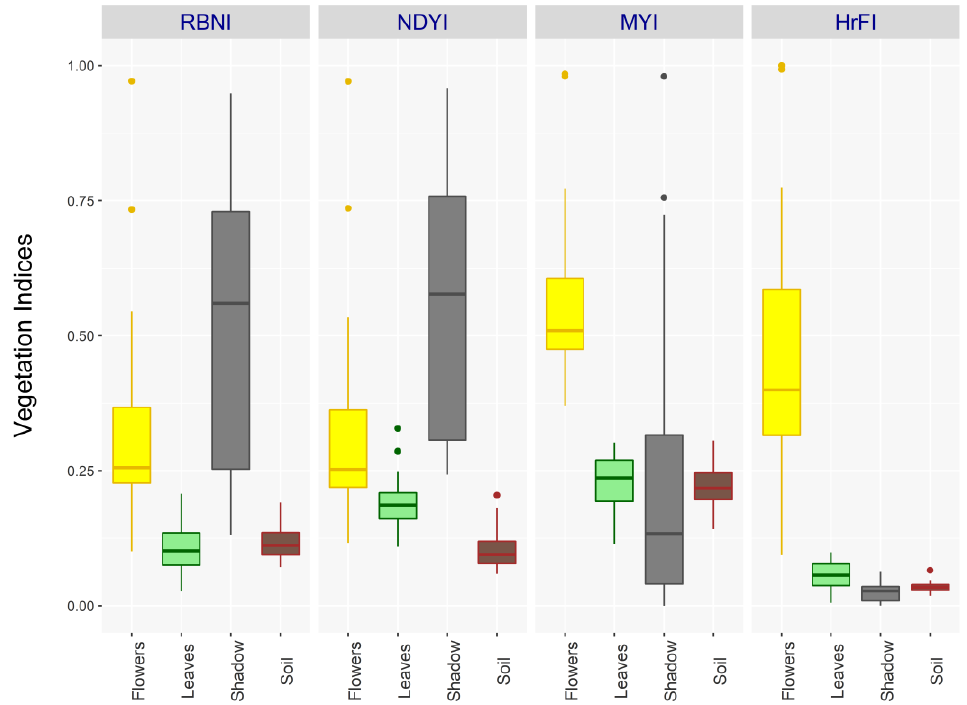
Figure 5. Boxplot comparing the distribution of pixel values in shadow, flowers, leaves, and soil classes for RBNI, NDYI, MYI, and HrFI. The four vegetation indices are normalized from 0 to 1 for ease of comparison. HrFI: High-resolution Flowering Index, RBNI: Red Blue Normalizing Index, NDYI: Normalized Difference Yellowness Index, MYI: Modified Yellowness Index.